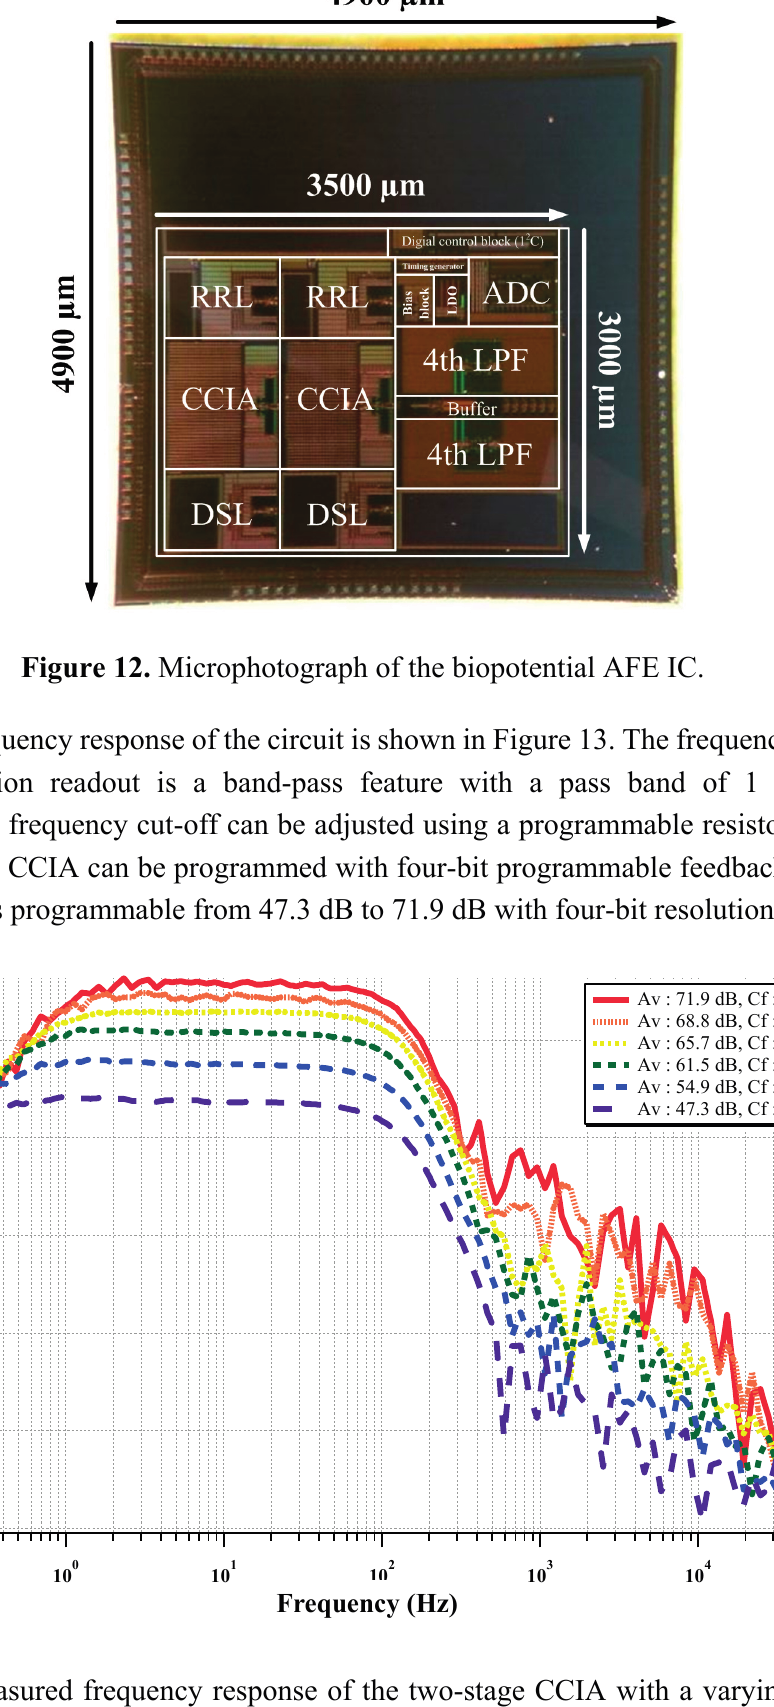
Figure 13. Measured frequency response of the two-stage CCIA with a varying feedback gain control